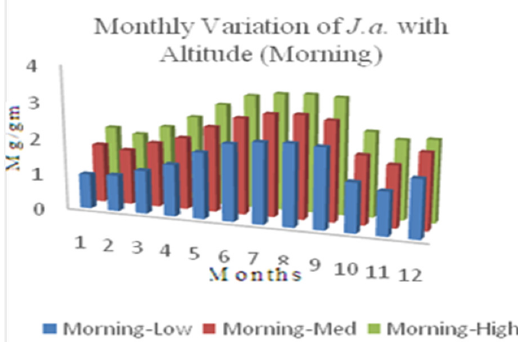
Figure 2. Monthly variation of with altitude (Morning) Mg/gm= Milligram/ gram, Med= Medium (altitude)